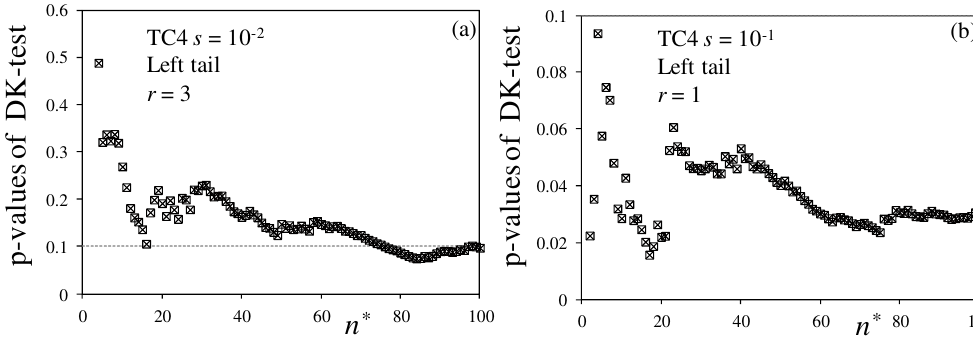
Fig. 11. DK test p values for TC4 and (a) r = 2 at s = 10 − 2 and (b) r = 1 at s = 10 − 1 .